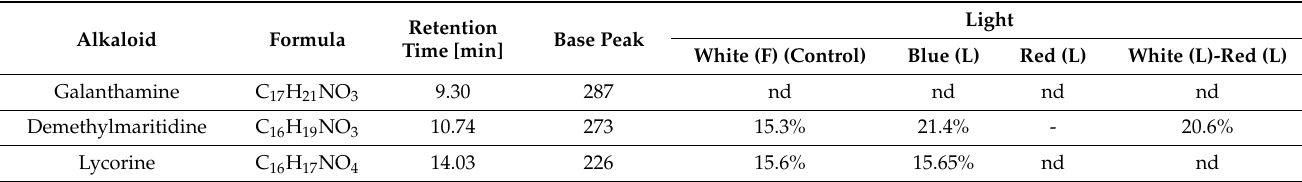
Table 5. Amaryllidaceae alkaloids identified by GC-MS (% of TIC) in L. aestivum in vitro plants grown in different light conditions. TIC: Total Ion Chromatogram, F: fluorescence, L: LED light, nd: not detected, (-): no